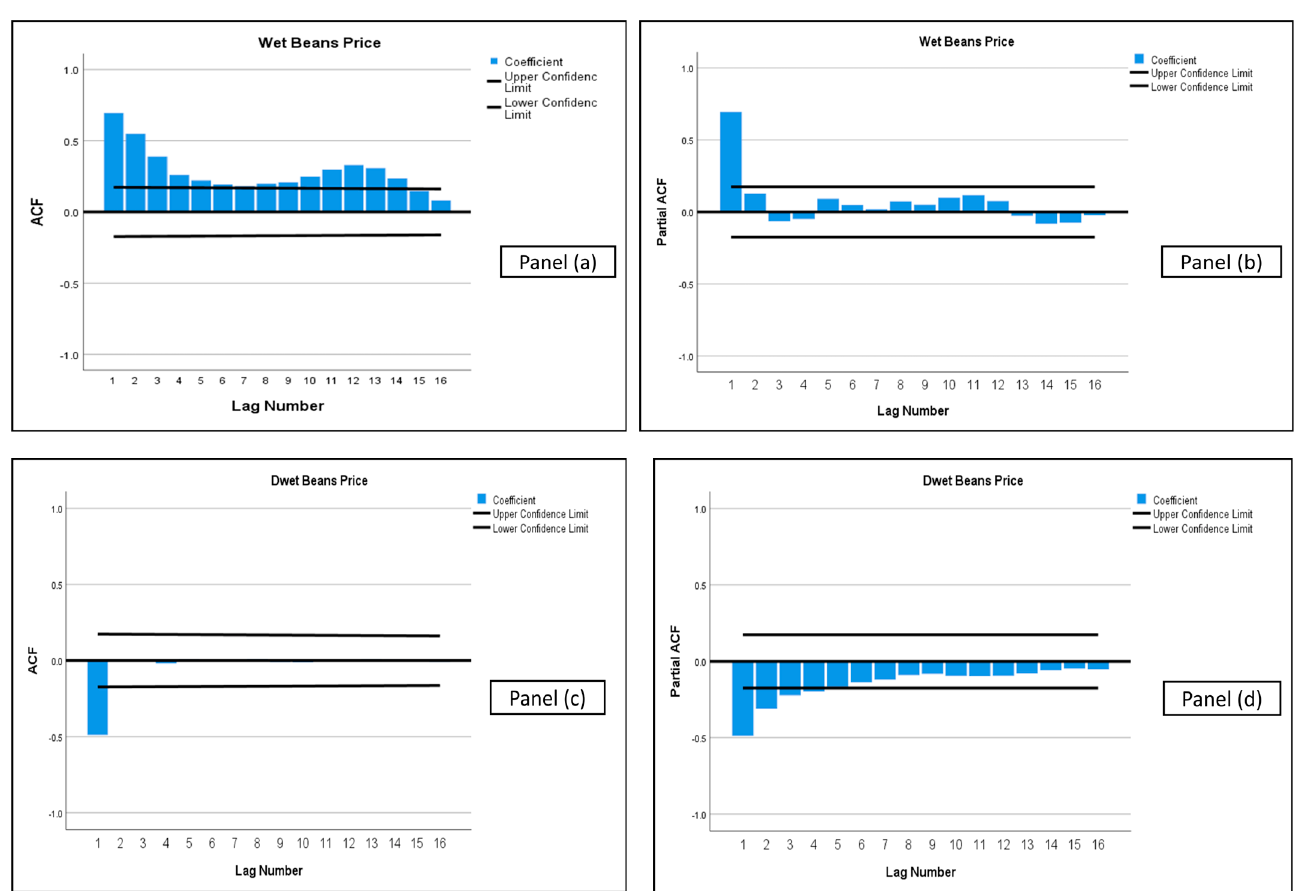
Figure 3. ( a ) The ACF correlograms for the raw Wet Cocoa beans price series; ( b ) The PACF correlo- Figure 3. The ACF and PACF correlograms for the raw and differenced Wet Cocoa beans price se- grams for the raw Wet Cocoa beans price series; ( c ) The ACF correlograms for the differenced Wet ries. Source: Authors processing using SPSS package. Cocoa beans price series; ( d ) The PACF correlograms for the differenced Wet Cocoa beans price